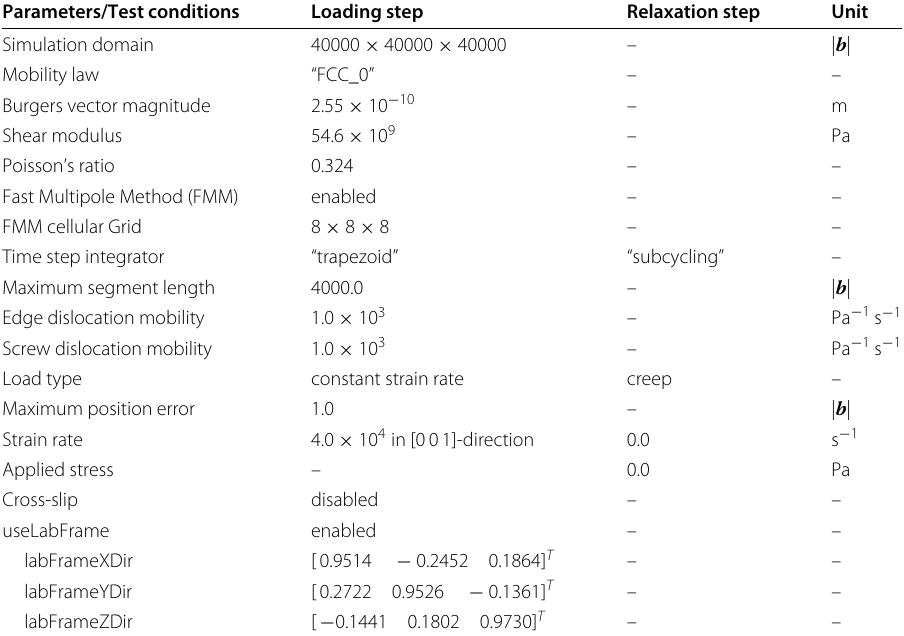
Table 1 DDD simulation parameters used to obtain a relaxed configuration of dislocations. Hyphens in the column ‘Relaxation step’ indicate unchanged status with respect to the ‘Loading step’ Parameters/Test